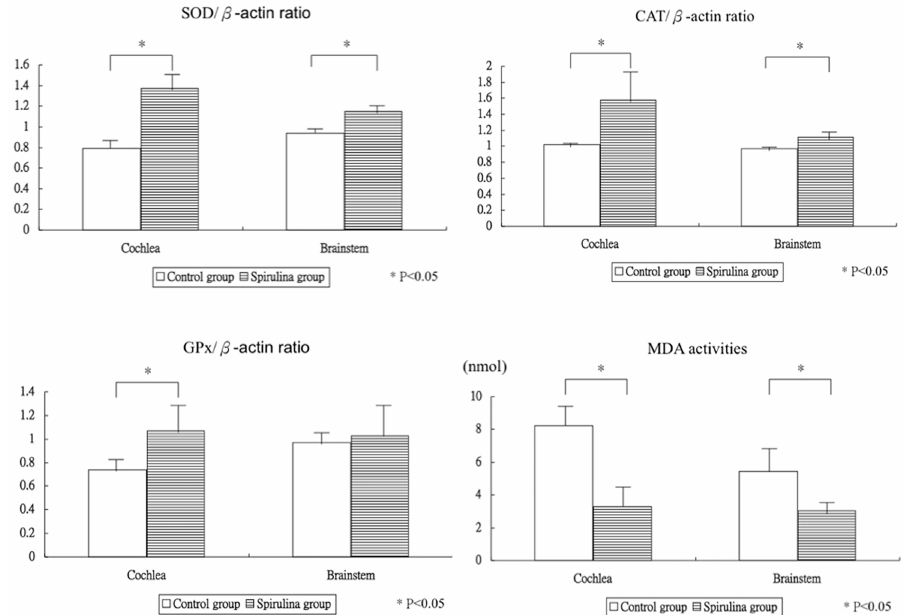
Fig 2. mRNA expressionof antioxidant and MDA levels at the end of this study. (a) The SP group had significantly higher expressionof the SOD gene in the cochleaand brainstem than the control group. (b) The SP group had higherexpressionof the CAT gene in the cochleaand brainstem than the control group. (c) Comparedwith the control group, the SP group had higherexpressionof the GPx gene in the cochlea,but not in the brainstem. (d) The SP group had significantly lower MDA activity in the cochleaand brainstem.